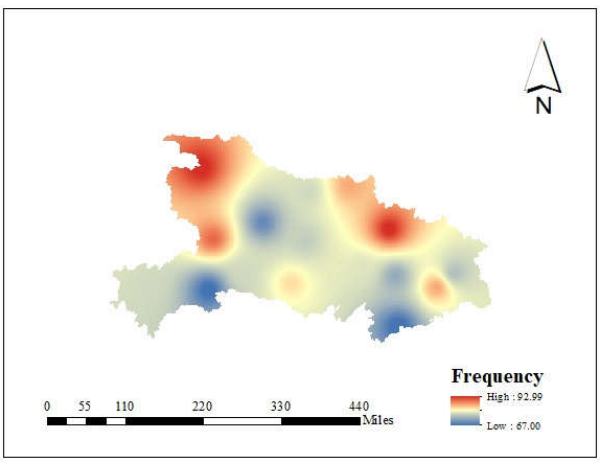
Figure 5. Spatial distribution of annual severe drought (D 2 -D 4 ) frequency for Hubei Province.